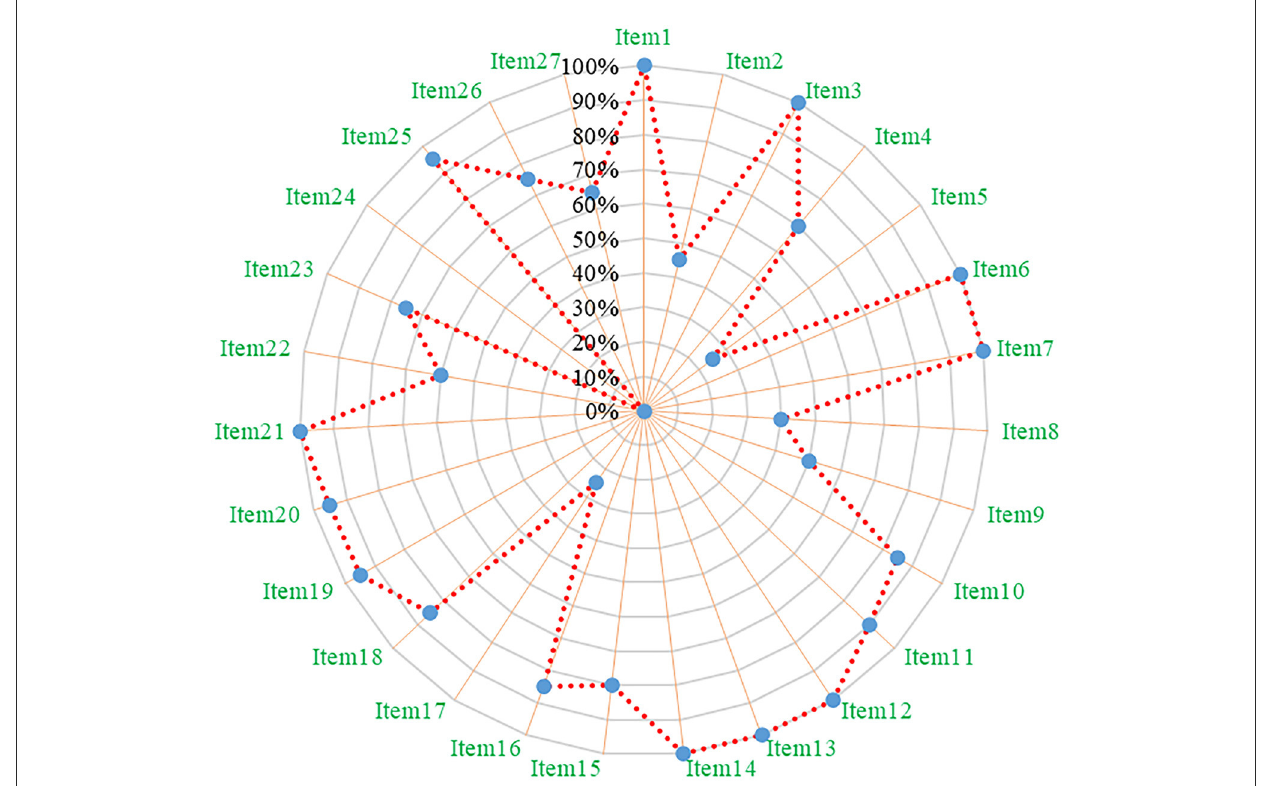
FIGURE2 Reporting quality of included meta-analyses based on the PRISMA 2009 statement.